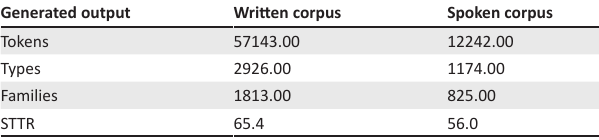
TABLE 2: Characteristics of the written and spoken corpora.